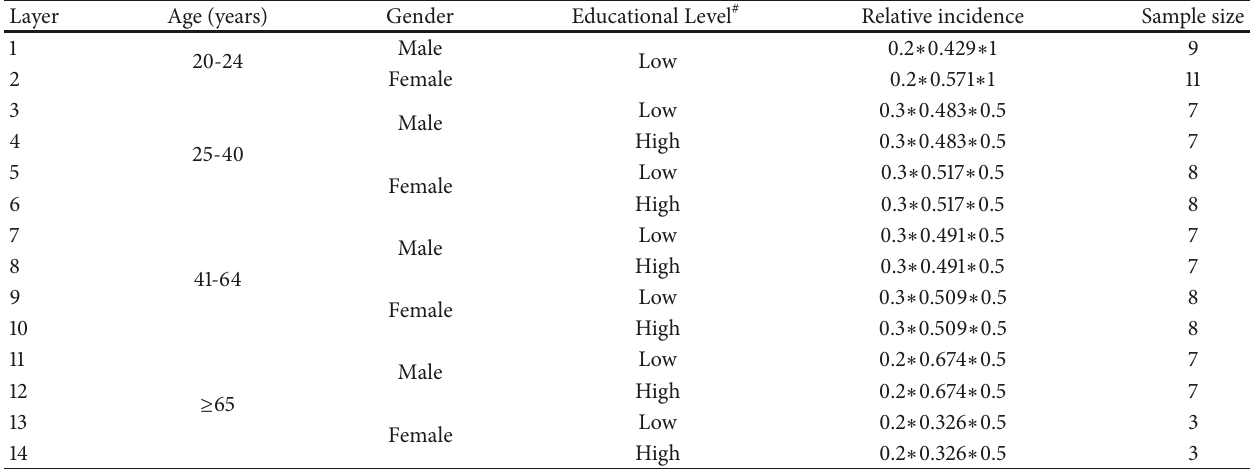
Table 1: Stratification of the sample used in this